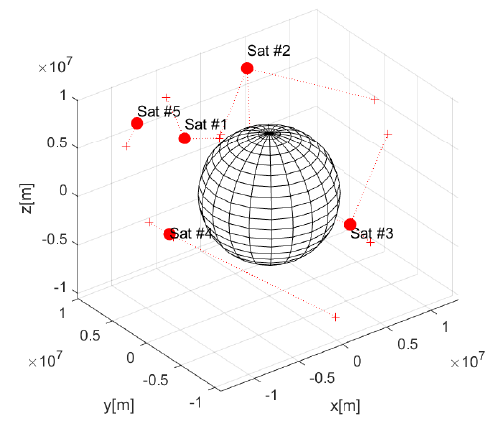
Figure 3. Task-planning visualization for example using baseline flat contract-net protocol (CNP) without hierarchical architecture. Filled circles, satellites; ‘+’, objects.